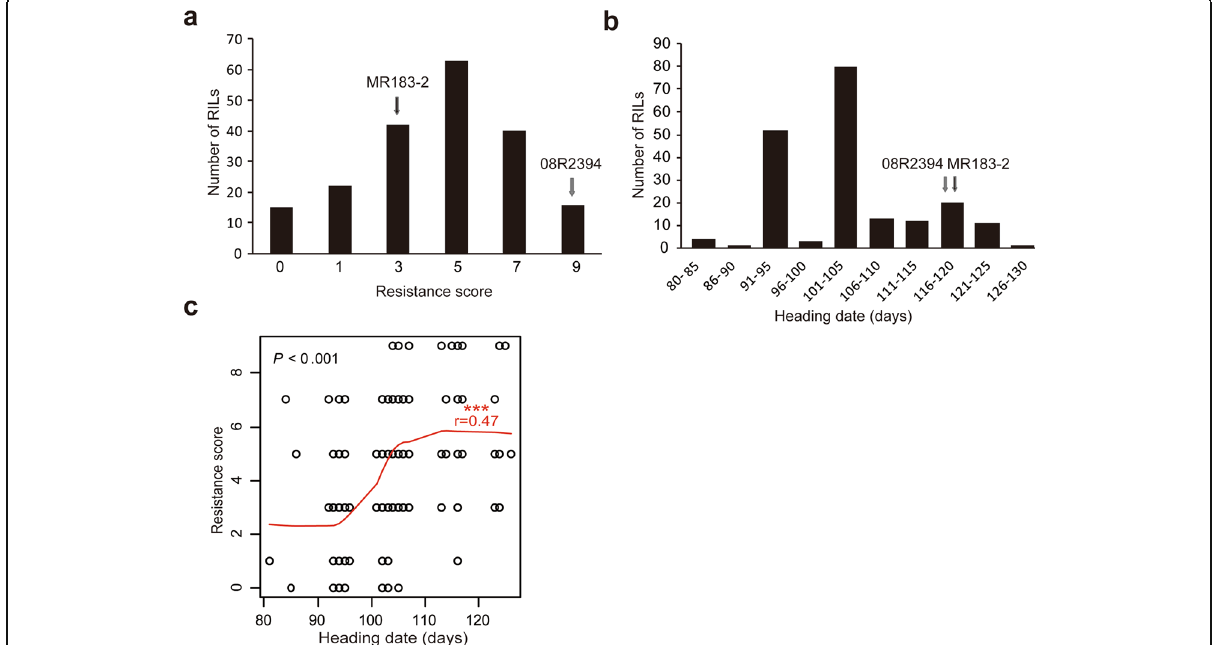
Fig. 2 Distribution of the resistance scores after natural infection, heading dates and phenotypic correlation between them in a RIL-F 7 population derived from the hybrid of MR183 – 2 and 08R2394. a Frequency distribution of 200 RILs for false smut resistance scores. Arrows indicate values of the parental lines. b Frequency distribution of 200 RILs for heading dates. c A significant positive correlation between false smut resistance score and heading date ( r = 0.47) was found in the RIL population by SPSS 20.0 software. *** represents a significant difference at P <